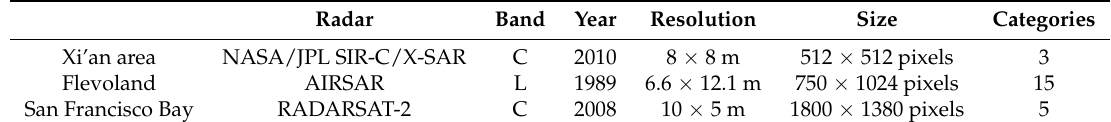
Table 1. Information on Three PolSAR Images.